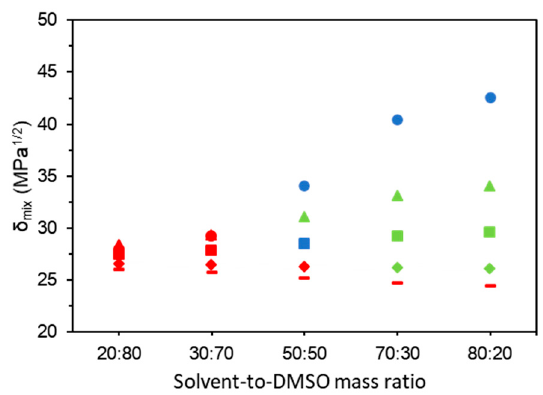
Figure 2. Solubility parameters of the mixture ( δ m ) for DMSO with ( ● ) water, ( ■ ) propylene glycol, ( ▲ ) glycerol, ( ♦ ) sulfolane, (-) and 2-dimethyl ethanolamine and gelation behavior of the samples, that is represented by colors: red = liquid; green = gel-like; blue = strong gel.